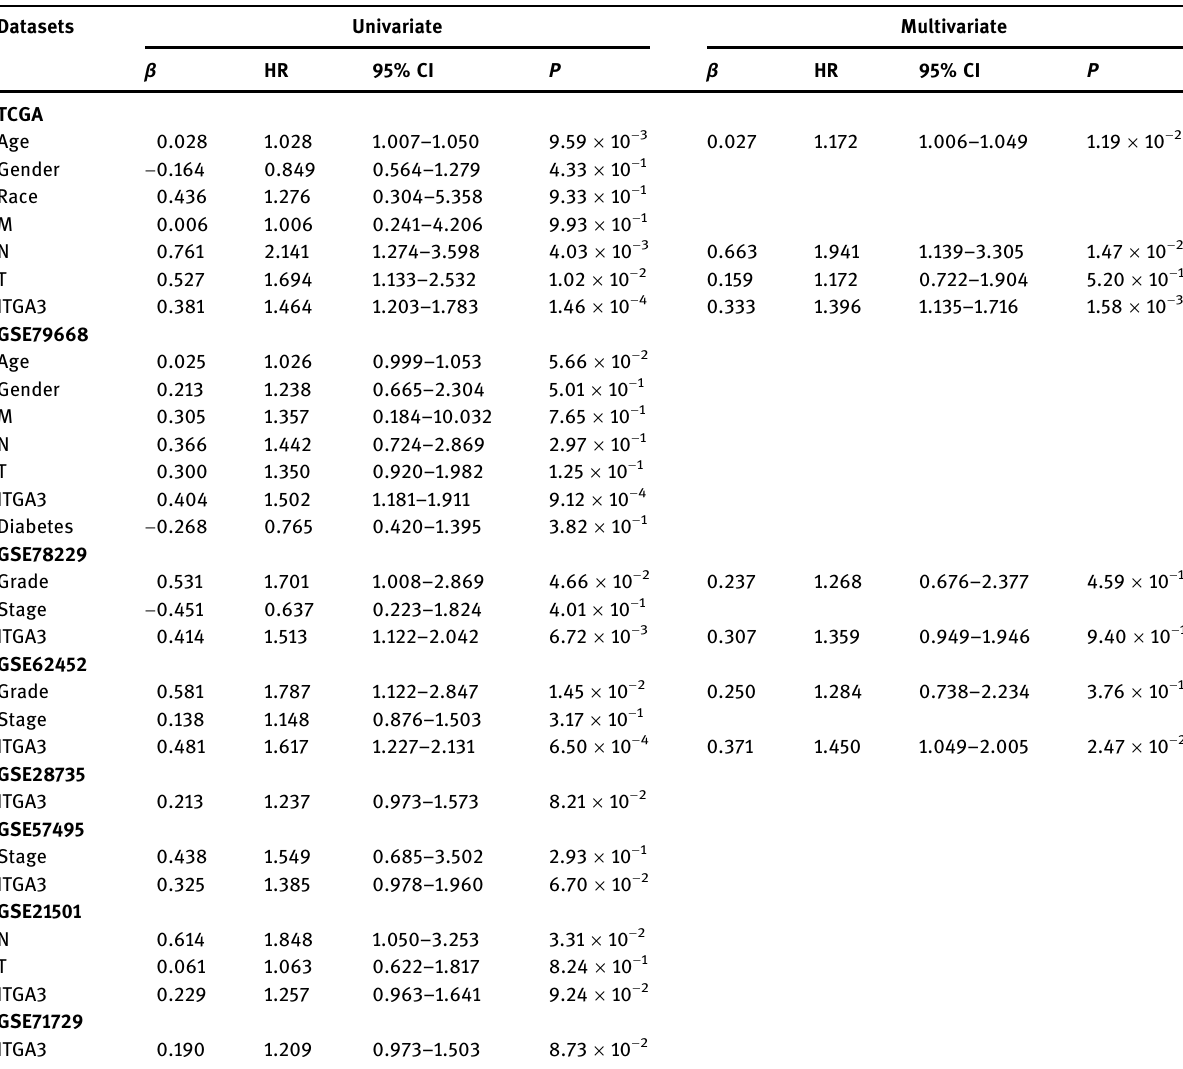
Table 3: The association of ITGA3 expression with overall survival in patients with PAAD by Cox regression analysis